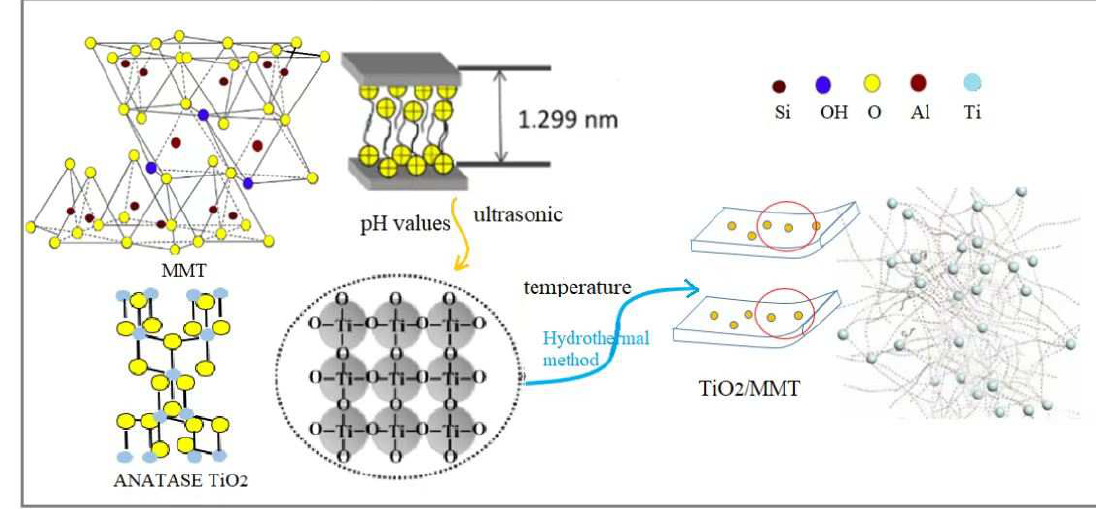
Figure 17. Schematic synthesis of TiO 2 –montmorillonite (MMT) composites.